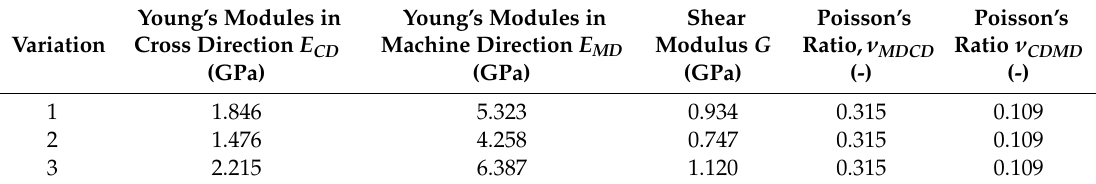
Table 2. Applied mechanical properties of the material.